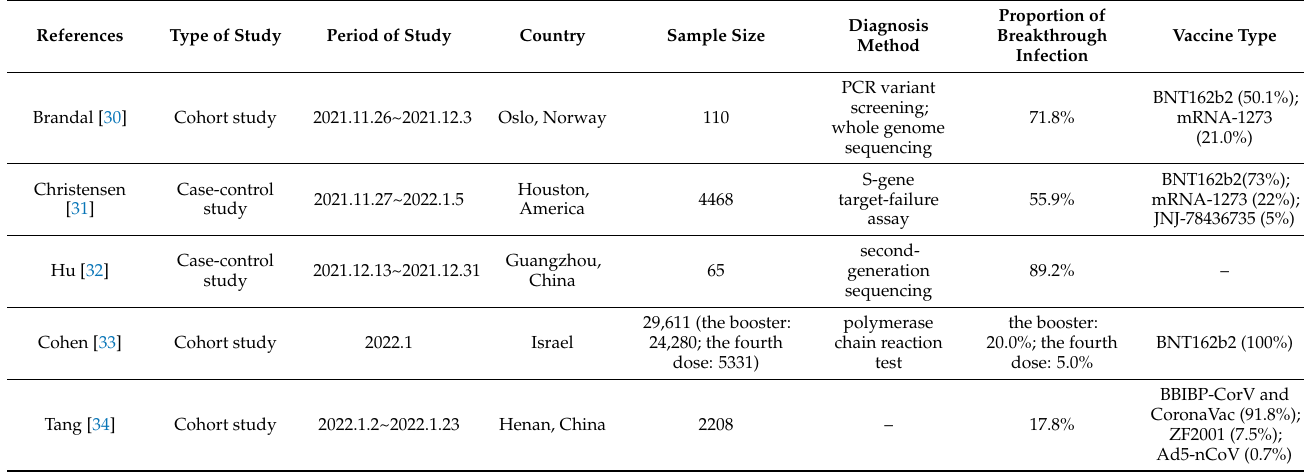
Table 1. Breakthrough infection caused by the Omicron variant in the